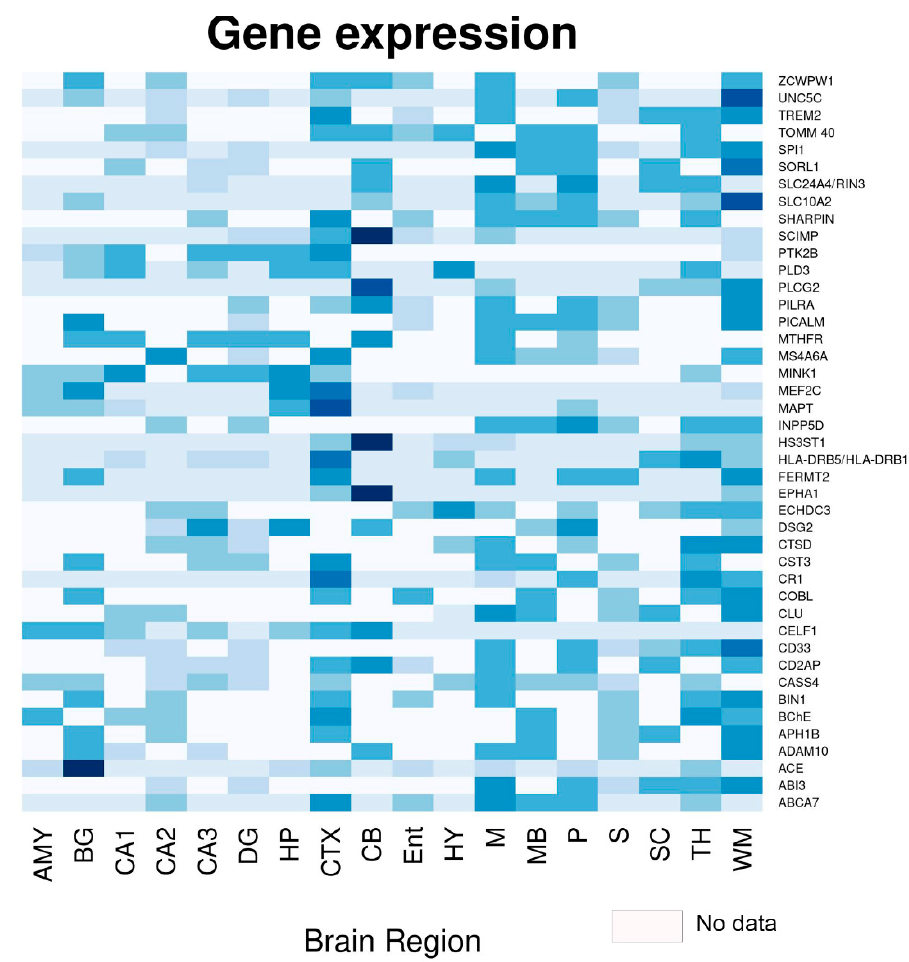
Figure 3. Heat map of the different genes associated with Alzheimer’s disease and their expressions in various regions of the brain and hippocampus. Abbreviations: AMY: Amygdala; BG: basal ganglia; CA1, CA2, CA3: Hippocampal regions; CB: Cerebellum; CTX: Cerebral cortex; DG: Dentate gyrus; Ent: Entorhinal gyrus; HP: Hippocampus; HY: Hypothalamus; M: Medulla oblongata; MB: Midbrain; P: Pons; S: Subiculum; SC: Spinal cord; TH: Thalamus; WM: White matter. Gene expression by brain region was obtained from the human protein atlas (https://www.proteinatlas.org/, accessed on 20 December 2022).